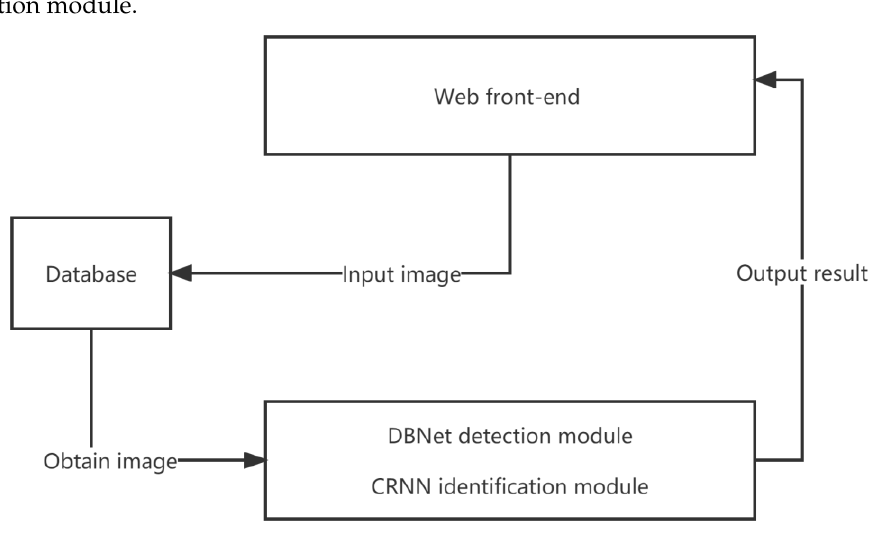
Figure 11. Training results of CRNN: ( a ) change in loss value and ( b ) variation in accuracy of validation datasets.